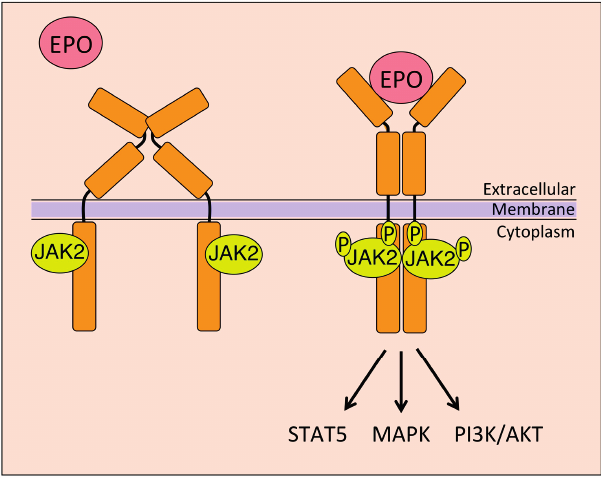
Figure 3. Model of erythroid EPO/EpoR signaling. The homodimeric EpoR molecule with Janus kinase 2 (JAK2) bound to its cytoplasmic domain is primed for EPO stimulation. EPO binding to the extracellular domain of EpoR results in conformational changes that bring JAK2 bound sites in close proximity to each other. This results in transphosphorylation of JAK2 and activation, which in turn increases other downstream signaling through signal transducer and activator of transcription 5 (STAT5), mitogen-activated protein kinase (MAPK) and phosphoinositide 3-kinase (PI3K)/AKT pathways.